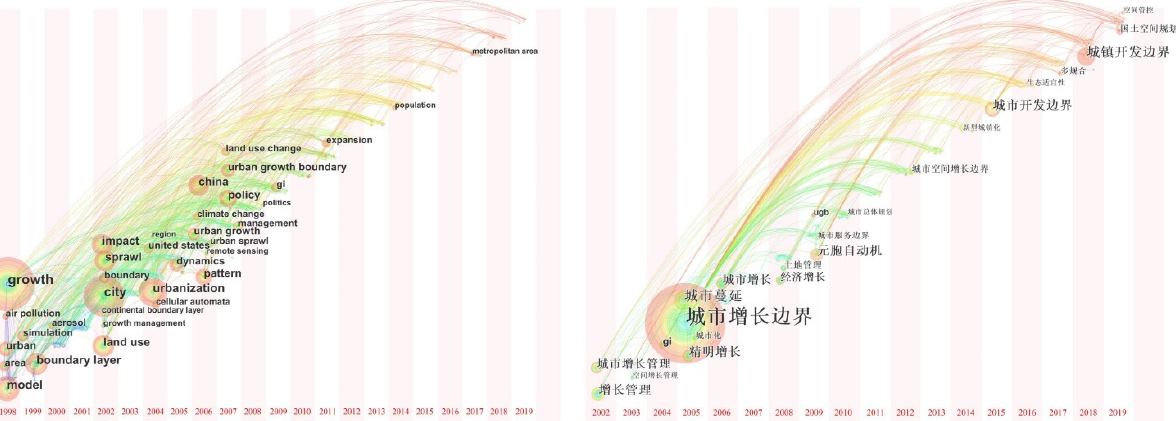
Figure 3. Time-zone maps of the evolution of high-frequency keywords in foreign languages ( left ) and Chinese ( right ) for the study of urban growth boundaries from 1998 to 2019. (Please refer to